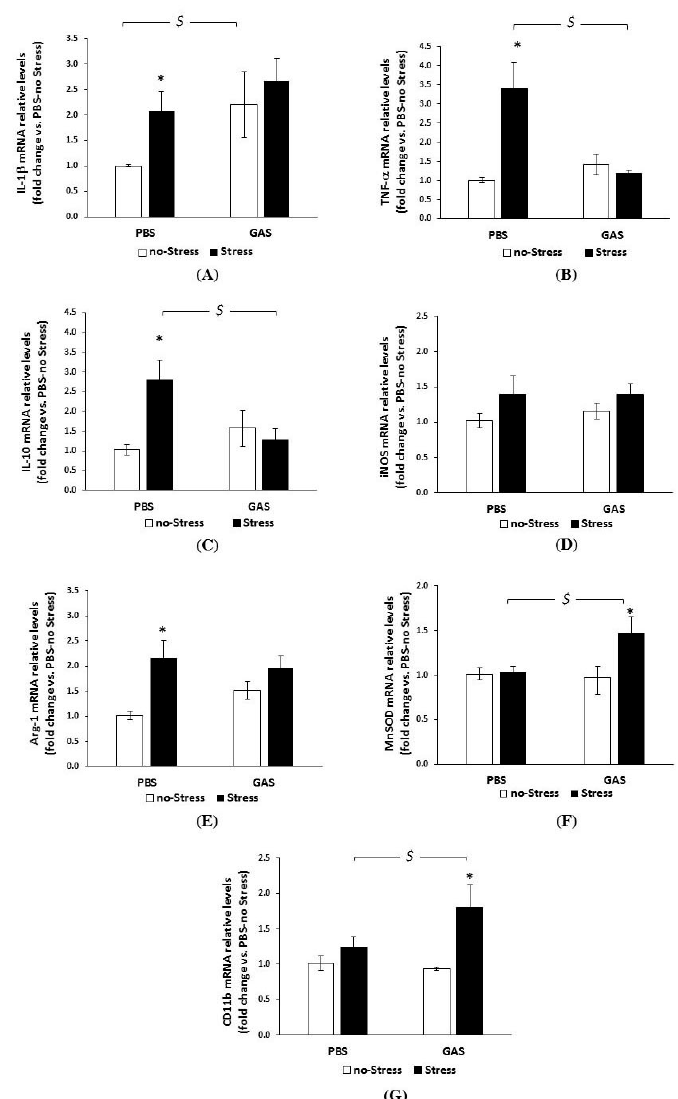
Figure 4. mRNA relative levels of inflammatory and oxidative stress-related markers in hypothalamus of GAS-Stress mice and relative controls. RT-PCR analysis was performed with mRNAs extracted from hypothalamus of control mice (PBS-no Stress), Group-A beta-haemolytic streptococcus injected mice (GAS-no Stress), psychosocially stressed mice (PBS-Stress) and mice exposed to haemolytic streptococcus and psychosocially stressed (GAS-Stress), at two weeks from treatment endings. Expression of each gene is presented as fold change over the expression measured in the hypothalamus of control mice (PBS-no Stress), taken as 1. The relative expression level of each mRNA was calculated using the 2- ∆∆ Ct method, normalized to hypoxanthine guanine phosphoribosyl transferase (HPRT), as detailed in the Materials and Methods section. Data are mean ± SEM, N = 4–6 per group. ( A ) IL-1 β mRNA levels: $ p < 0.05 for GAS-no Stress vs. PBS-no Stress; * p < 0.05 for PBS-Stress vs. PBS-no Stress. ( B ) TNF- α mRNA levels: $ p < 0.05 for GAS-Stress vs. PBS-Stress; * p < 0.05 for PBS-Stress vs. PBS-no Stress. ( C ) IL-10 mRNA levels: $ p < 0.05 for GAS-Stress vs. PBS-Stress; * p < 0.05 for PBS-Stress vs. PBS-no Stress. ( D ) iNOS mRNA levels. ( E ) Arg-1 mRNA levels: * p < 0.01 for PBS-Stress vs. PBS-no Stress. ( F ) MnSOD mRNA level: $ p < 0.05 for GAS-Stress vs. PBS-Stress; * p < 0.05 for GAS-Stress vs. GAS-no Stress. ( G ) CD11b mRNA levels: $ p < 0.05 for GAS-Stress vs. PBS-Stress; * p < 0.05 for GAS-Stress vs. GAS-no Stress. Cohen’s d measures are reported in Table